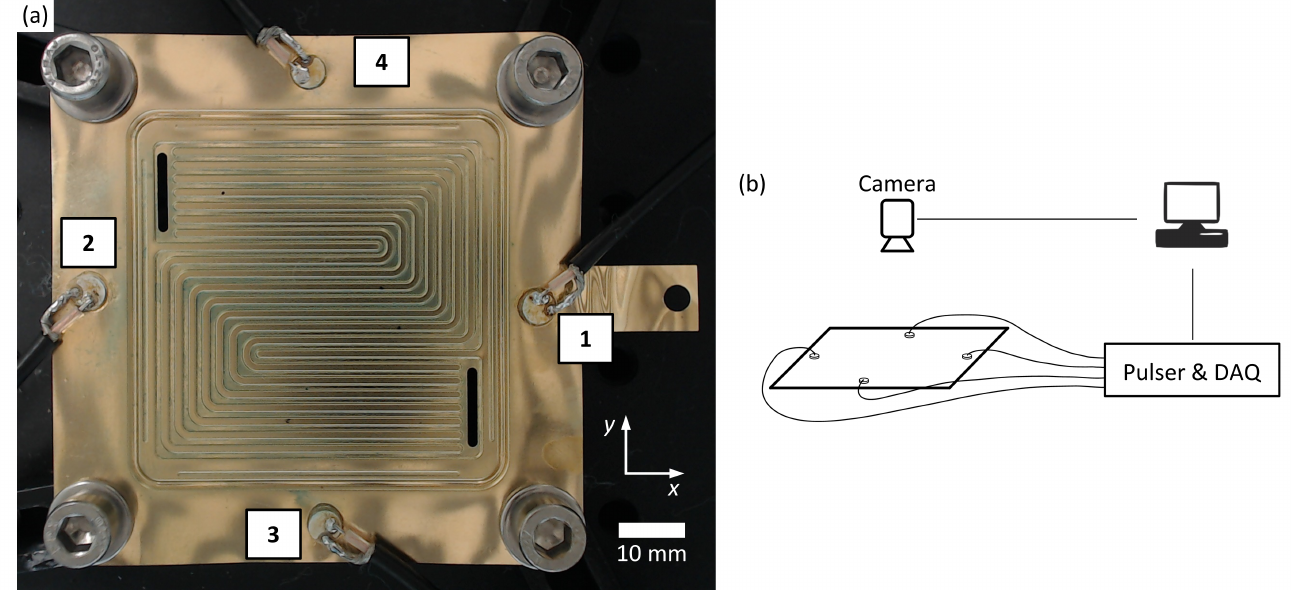
Figure 1. ( a ) Bipolar plate with four PWAS connected to it. The flow field in the center consists of eight serpentine flow channels, which connect the gas inlet and outlet. ( b ) Scheme of the experimental setup showing the camera, pulser, and data acquisition system (DAQ) connected to a